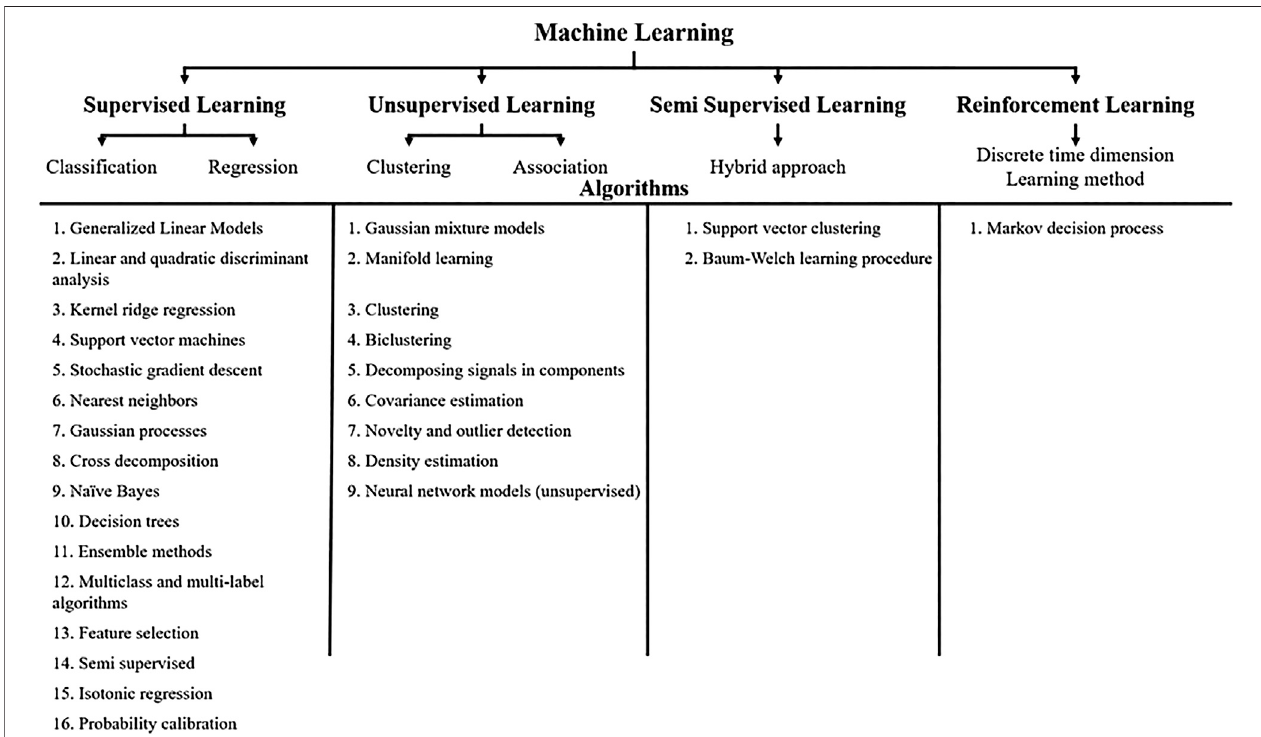
FIGURE 1 | Machine Learning Types & algorithms (Adapted from Ahmed and Khan,